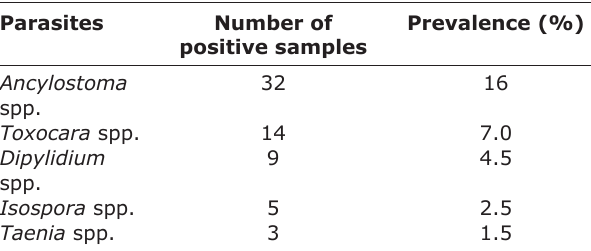
Table-2: Prevalence of gastrointestinal infection by genera in dogs ( Canis familiaris ) in Maiduguri, Borno State, Northeastern